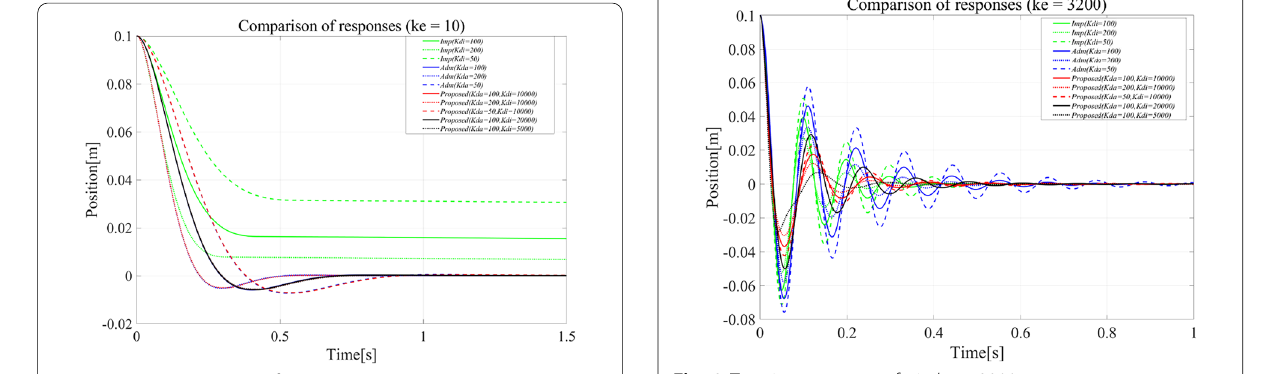
Fig. 4 Transient response of x in k e = 10